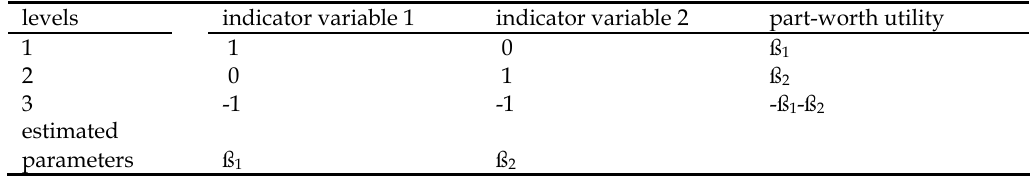
Table 2 . Effects-coding for three-level attributes levels indicator variable 1 indicator variable